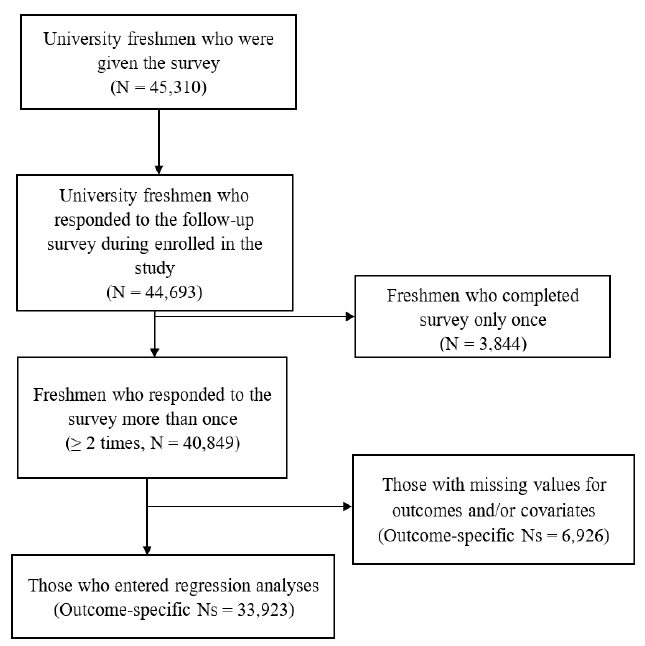
Figure 1. Study Sample Flowchart. Table 1. Baseline characteristics of survey participants.